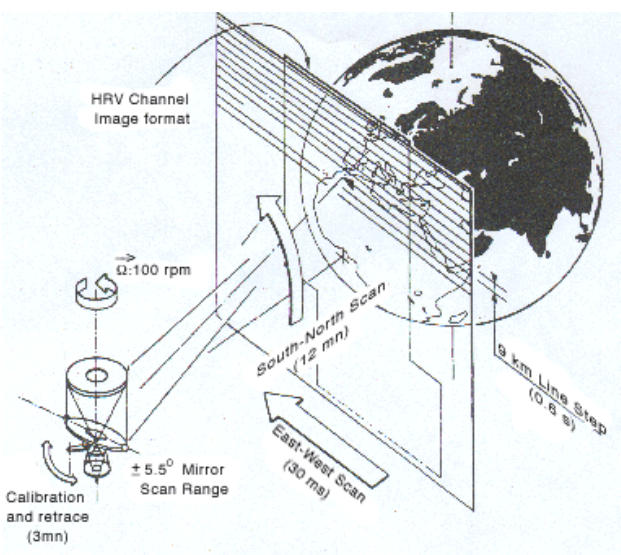
Figure 1. SEVIRI Earth imaging principle